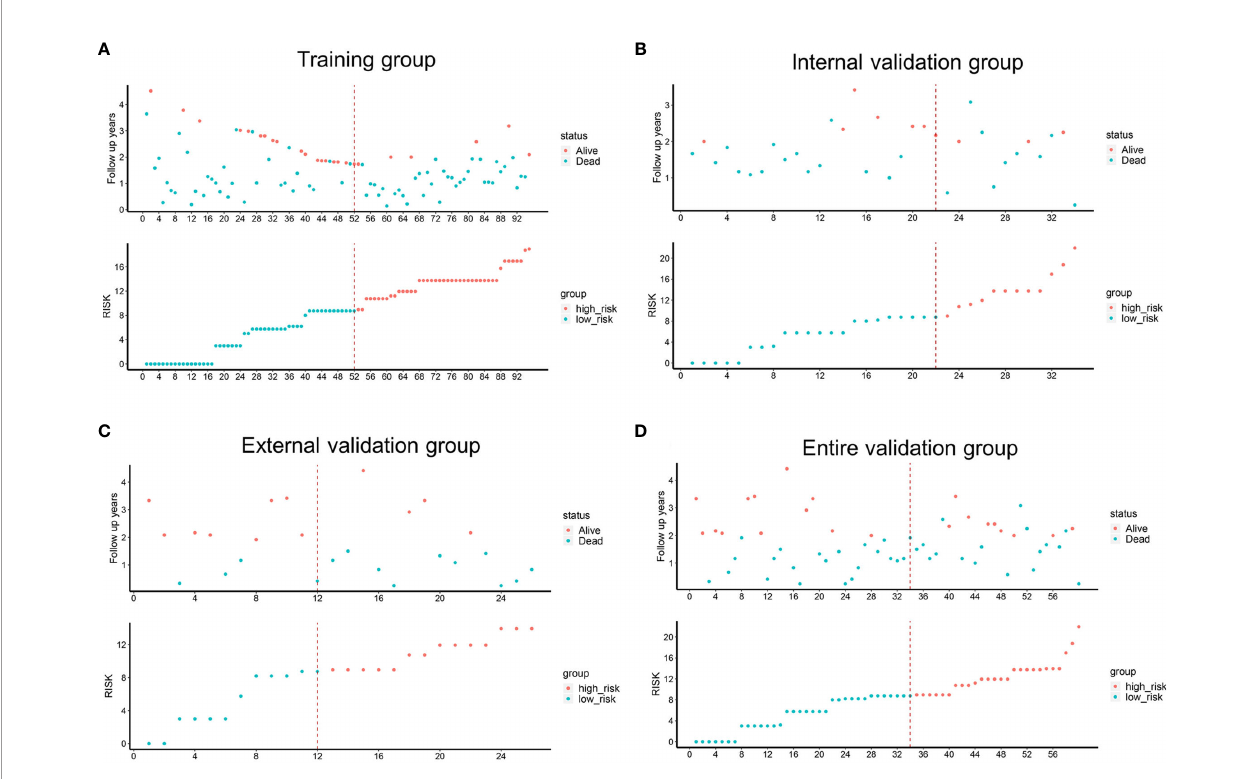
FIGURE 5 | Risk factor correlation diagrams of the training, external validation, internal validation and entire validation groups. The red dots in the fi gure represented the surviving PDAC patients, and the blue dots represented the dead PDAC patients. The dotted line represented the median value of risk score. The left side of the dotted line represented the low-risk group, and the right side of the dotted line represented the high-risk group. (A) risk factor correlation diagram of the training group; (B) risk factor correlation diagram of the external validation group; (C) risk factor correlation diagram of the internal validation group; (D) risk factor correlation diagram of the entire validation